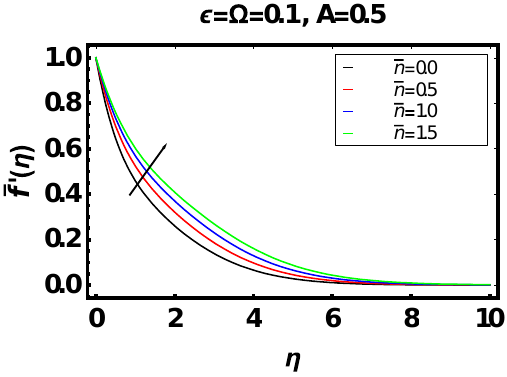
Figure 4. Velocity along x -direction for variant n .